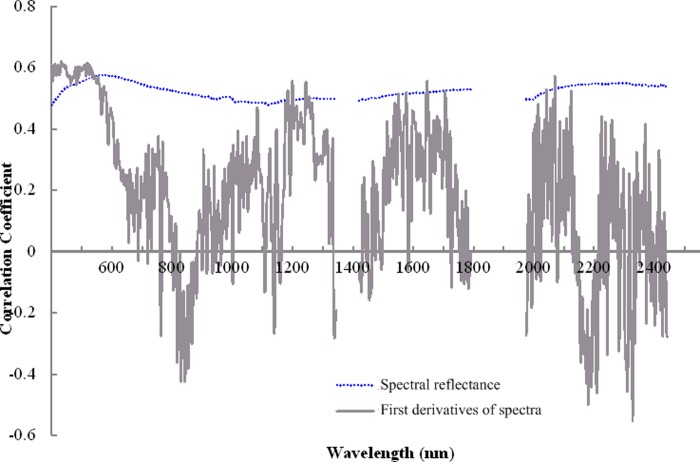
Correlation curves.The figure shows the correlation curve between reflectance spectra and SDI, and the correlation between the first derivative of spectra and SDI.